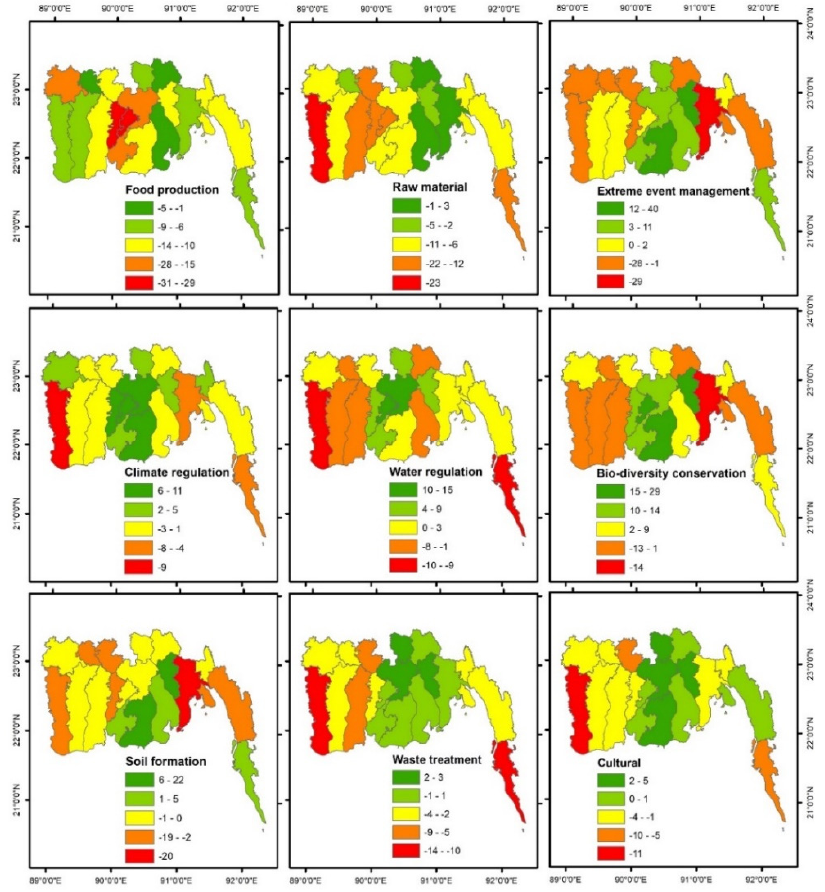
Figure 6. District-level changes (%) of ESVs under different ecosystem functions between 1999 and 2019 in CRB.